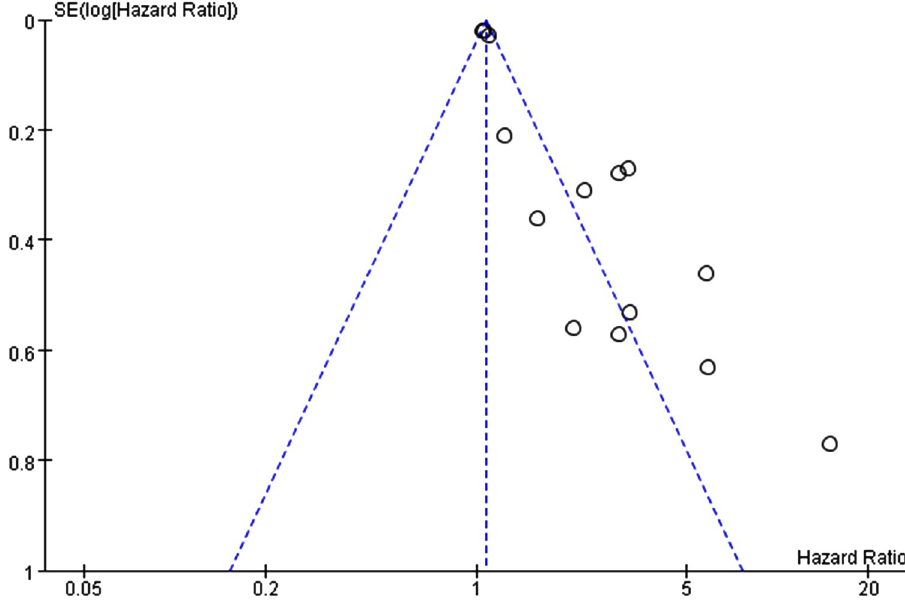
The shape of the funnel plot was asymmetric and deviated from the dotted line (Fig 4), and Egger’s test was statistically significant ( P < 0.05) (Fig 5), indicating the presence of publication bias, which was adjusted by the trim and fill method. After adding seven studies, the funnel plot was symmetrical and concentrated (Fig 6), but the result was not statistically significant (HR = 1.15, 95%CI: 0.98–1.35, P = 0.082).